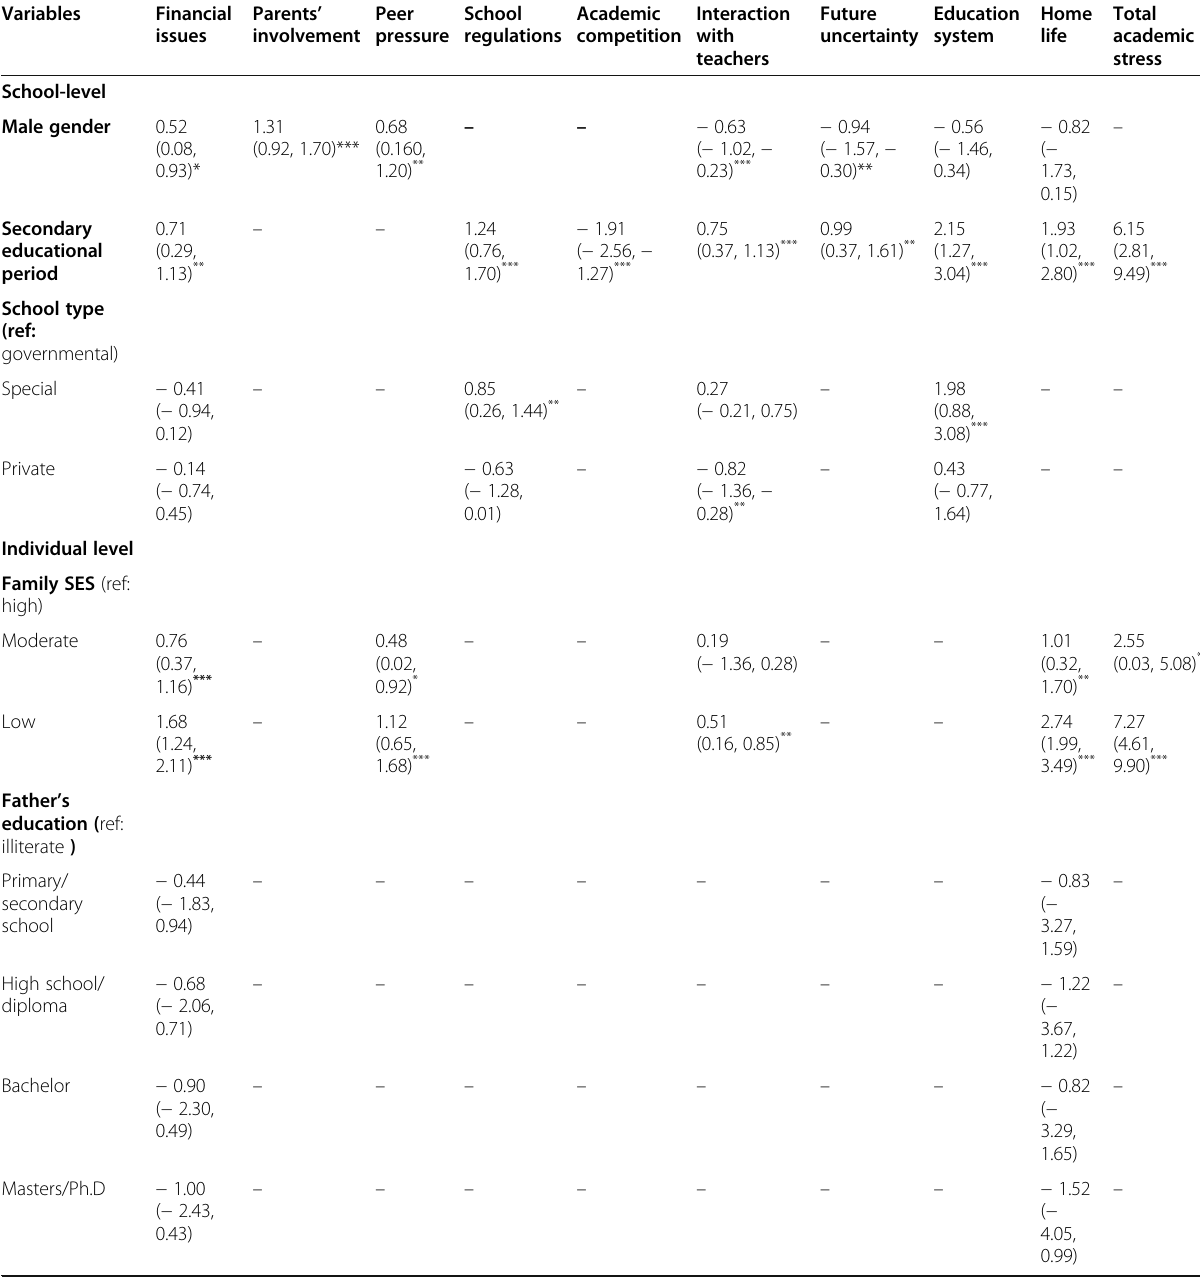
Table 4 Multilevel multiple linear regression analysis of variables associated with the sources of academic stress among adolescents in Qazvin, Iran ( n = 1724)